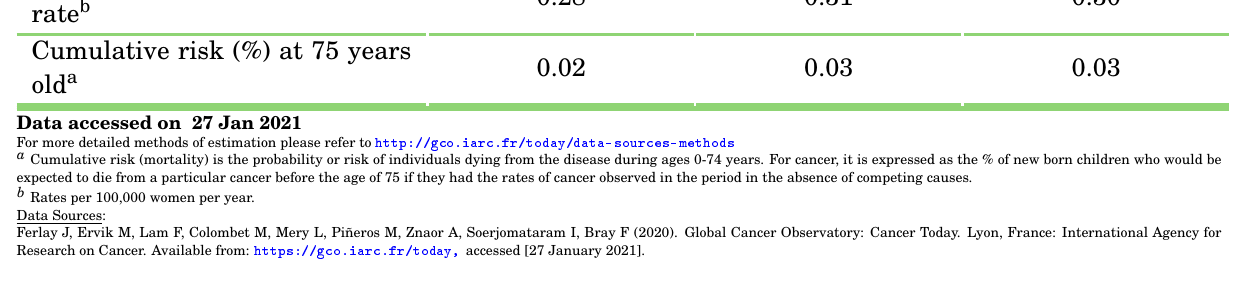
Table 10: Vulva cancer mortality in Peru (estimates for 2020) Indicator Peru South America World Annual number of deaths 68 1,099 Uncertainty intervals [95% UI] [50-92] [976-1,238] Crude mortality rate b 0.41 0.50 0.45 Age-standardized mortality rate b